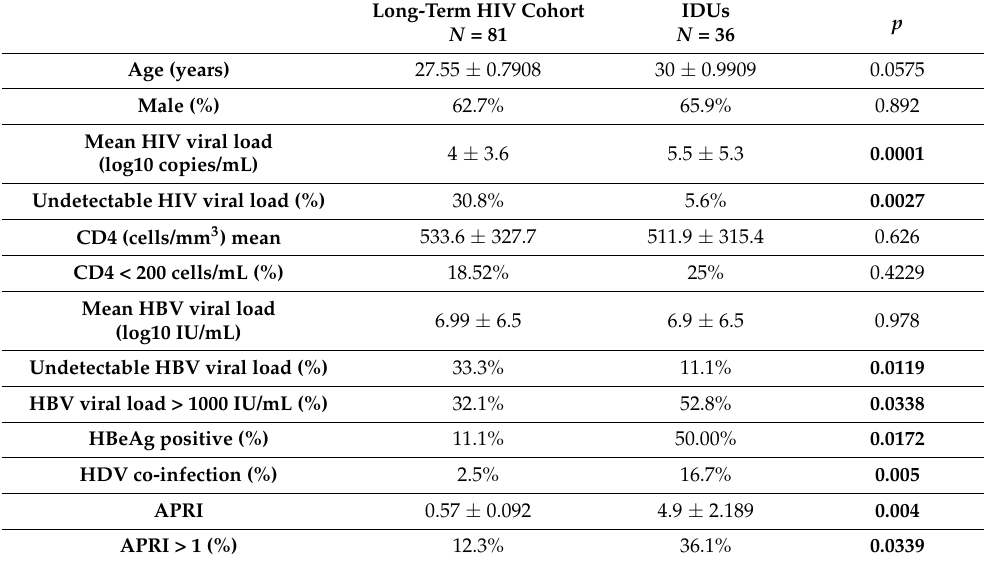
Table 1. Patients’